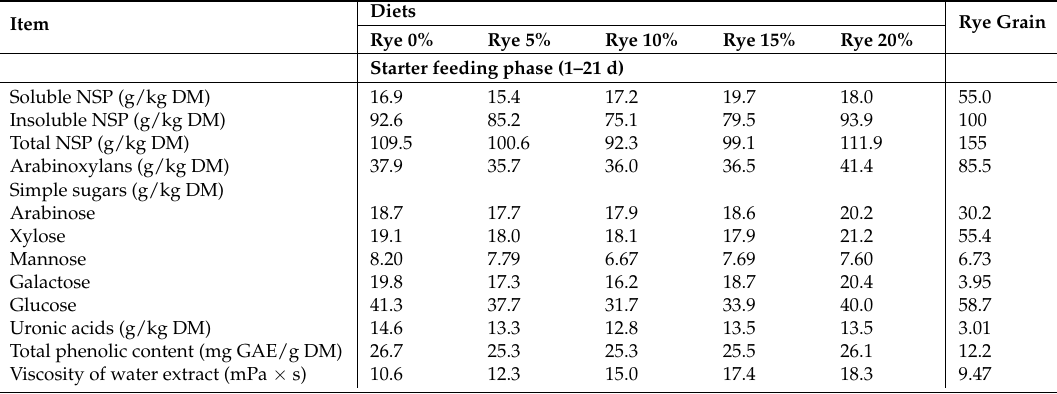
Table 2. Chemical composition and viscosity of water extracts of the experimental diets and rye